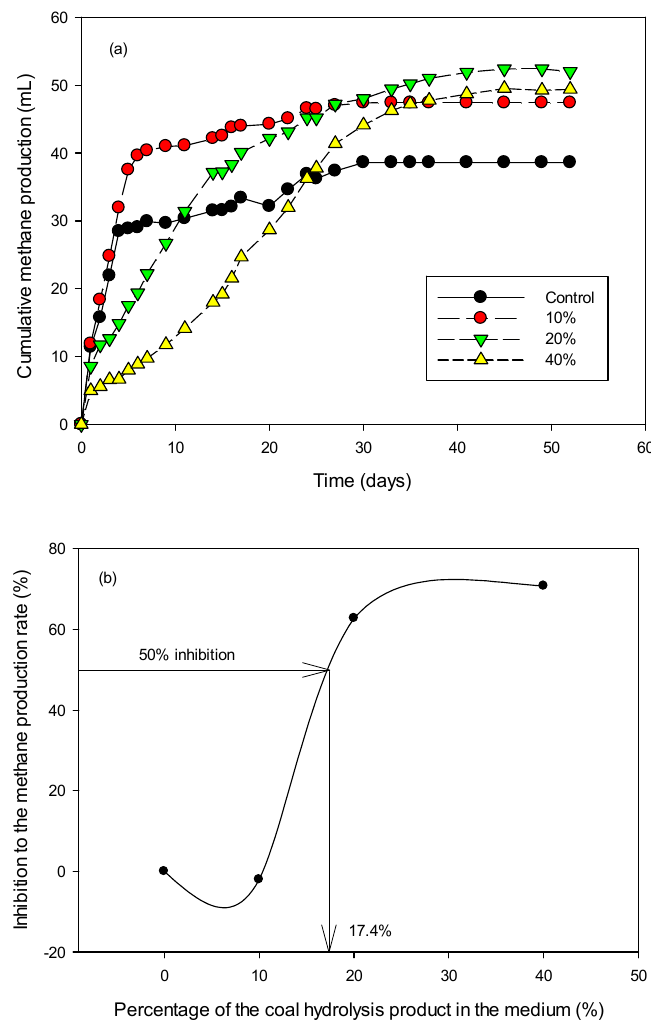
Figure 5. ( a ) Cumulative methane production and ( b ) the inhibition to the methane production depending on the amount of the coal hydrolysis product added in the anaerobic toxicity test.